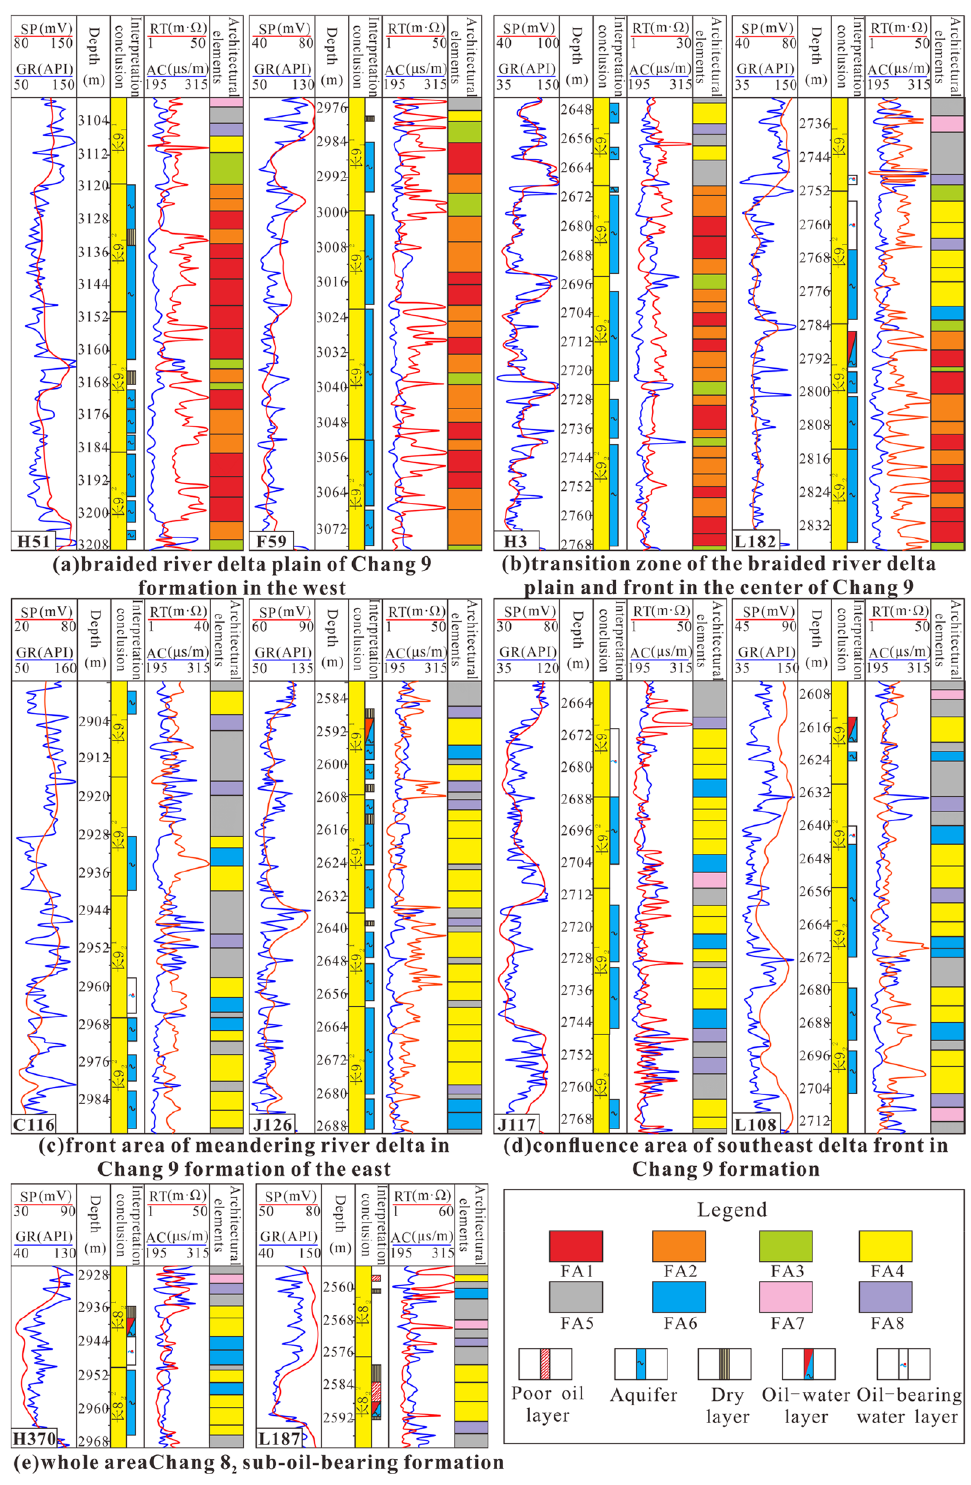
Figure 13. Vertical combination characteristics of architectural elements (Note: SP, GR, RT, AC are abbreviations of logging curve types and are consistent with the meanings in the above